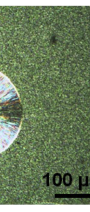
Figure 6. The optical micrograph showing the dual morphology of the iPBu samples prepared by crystallizing from melt first at 90 °C isothermally for 10 min and then quenching to room temperature. Reproduced with permission from Ref. [49], copyright 2013 Elsevier Ltd.